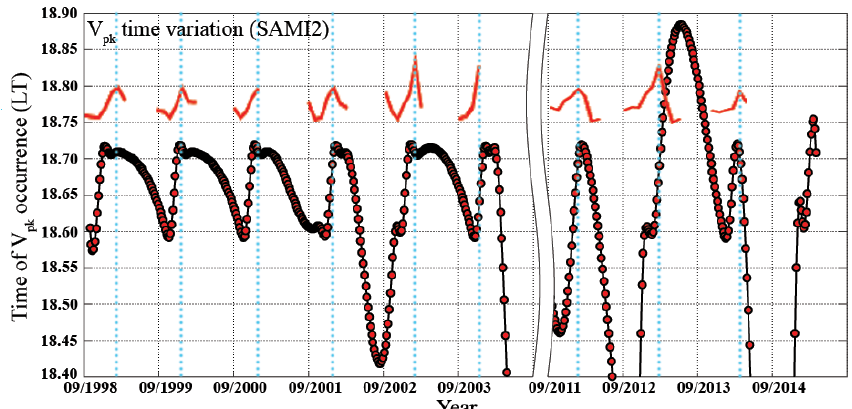
Figure 6. Temporal variation of V pk and S 4 activity onset. The red circles denote the local time of V pk occurrence, and the coral curves represent the pattern of S 4 activity onset. The dashed blue line shows the clear phase correspondence between V pk time and S 4 activity